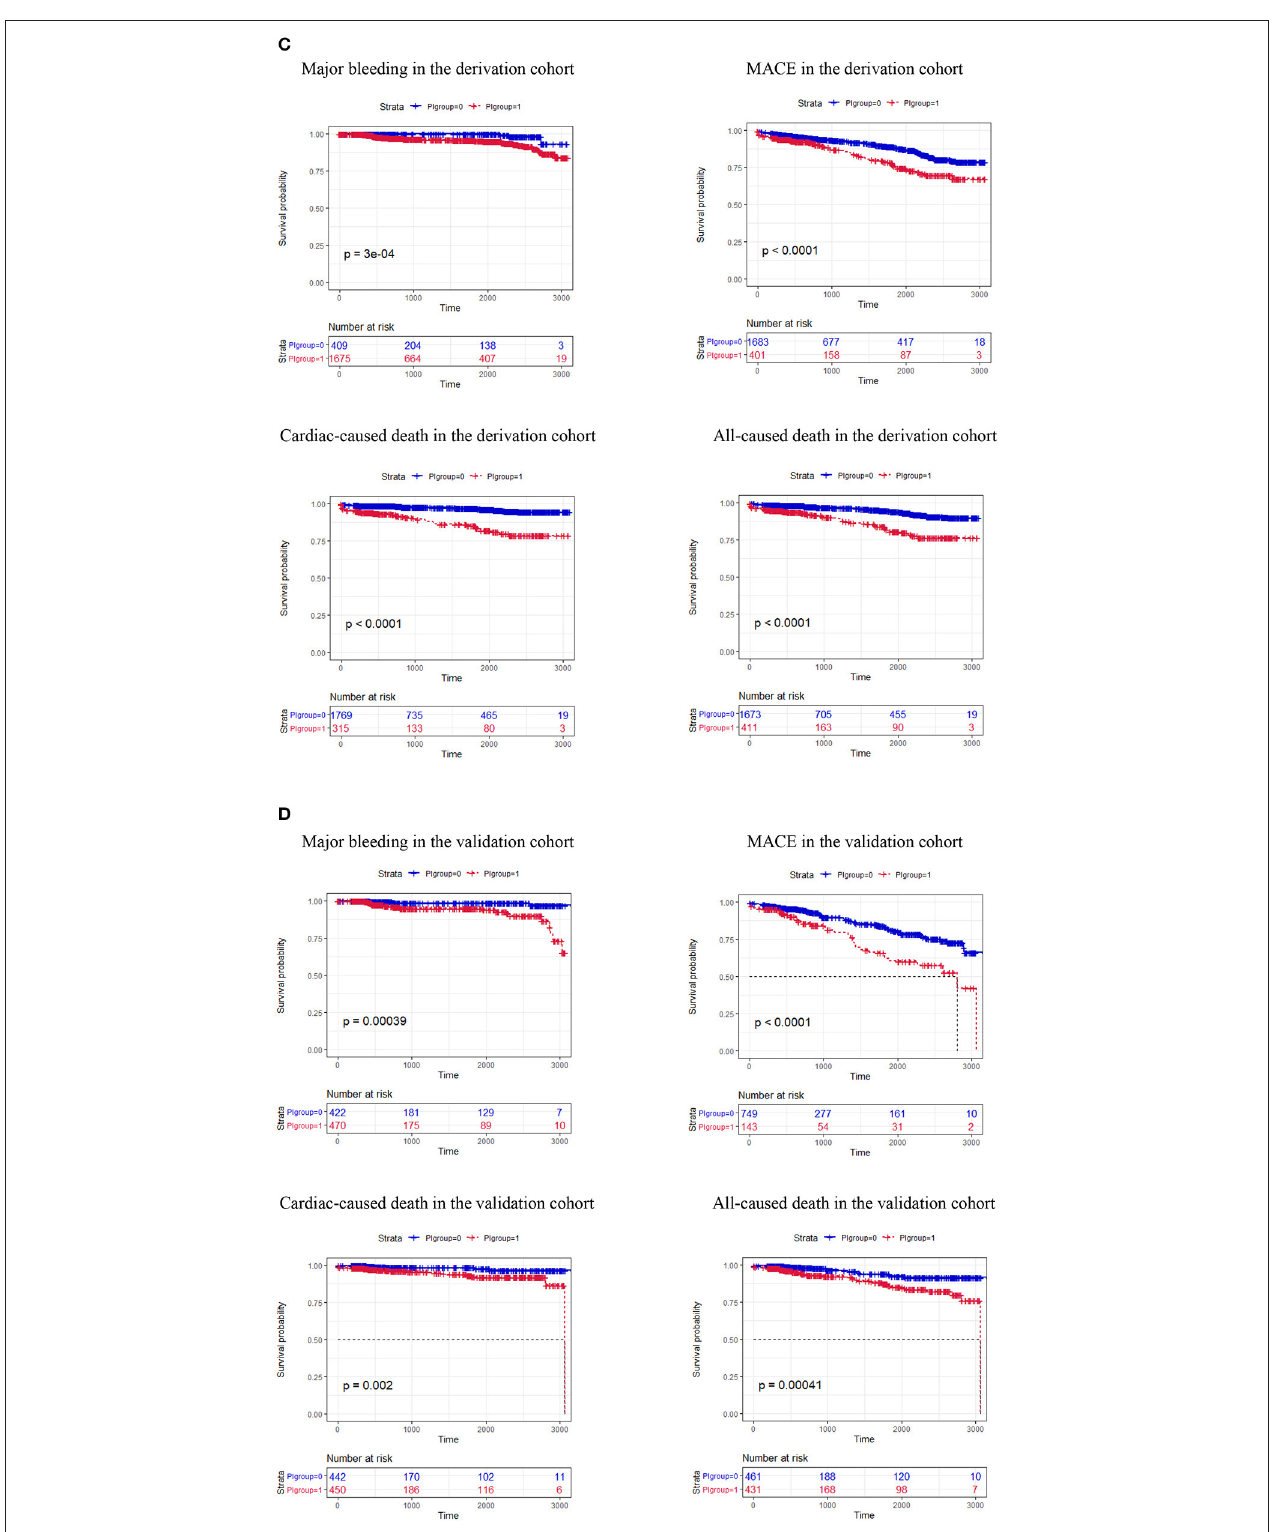
FIGURE 2 | (A) Cumulative 3-year incidence of thrombotic events ( p = 0.0022), MACEs ( p = 0.019), cardiac-caused death ( p = 0.076), and all-caused death ( p = 0.012) according to the thrombotic risk score categories in the derivation cohort ( N = 2,084). (B) Cumulative 3-year incidence of thrombotic events ( p = 0.023), MACEs ( p = 0.00057), cardiac-caused death ( p = 0.0024), and all-caused death ( p = 0.00057) according to the thrombotic risk score categories in the validation